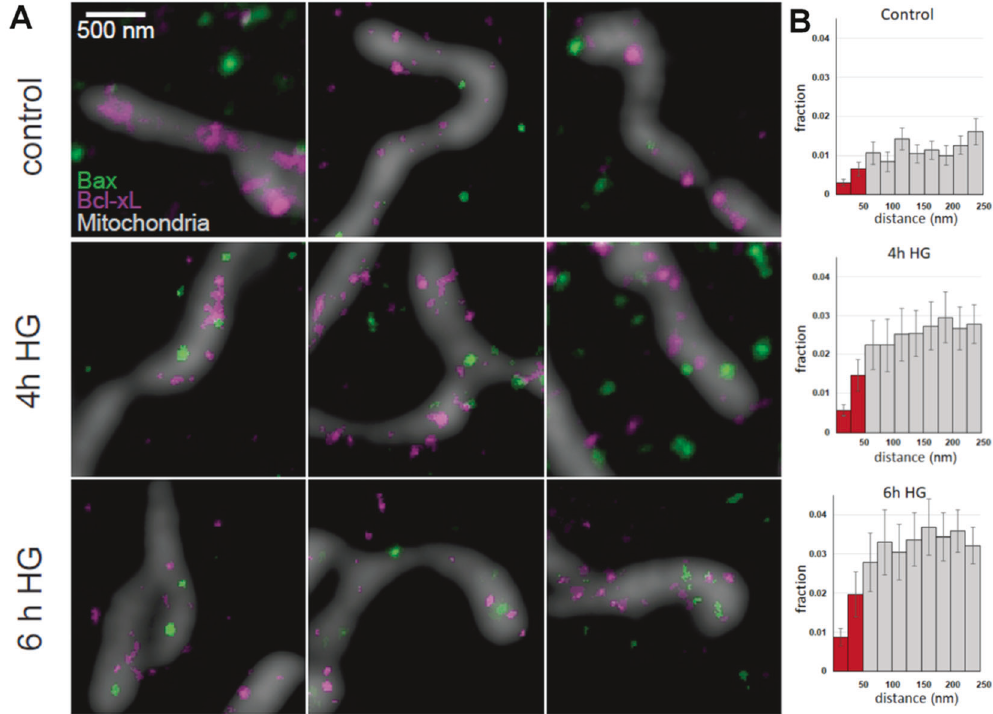
Fig. 2 Stimulated emission depletion (STED) micrographs and nearest neighbor analysis of mitochondria, Bcl-xL, and Bax in high glucose (HG)-treated proximal tubular cells (PTCs). A Representative images showing the distributions of Bax (green) and Bcl-xL (magenta) together with mitochondria (gray). The top row shows untreated (5.6 mM glucose) cells. The second and third rows show cells treated with HG for 4 and 6 h, respectively. B Nearest neighbor analysis of interactions based on the accumulated statistics for distances between Bcl-xL and Bax measured by super-resolution STED microscopy. Bars show the fractions of proteins with a separating distance indicated at x axis. The <50 nm distance fraction (red) is considered indicative of a molecular interaction. N = number of micrographs from different cells obtained from 3 or more cell culture preparations; 31 in control, 36 in 4 h HG, and 28 in 6 h